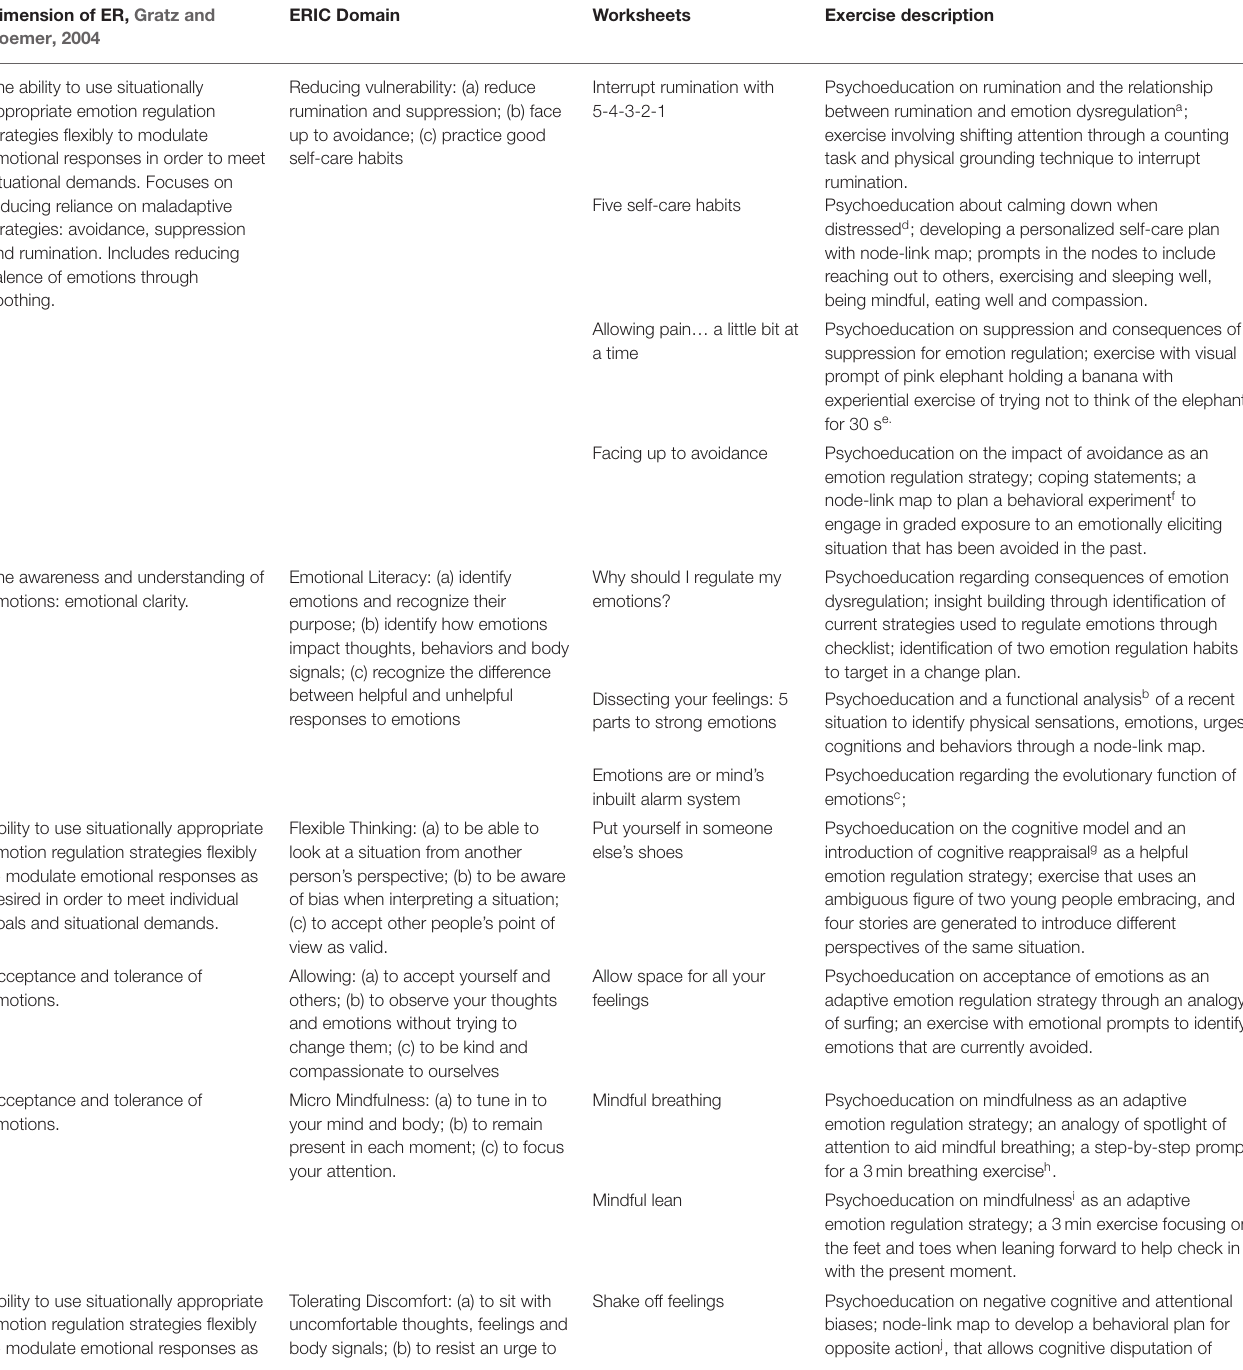
TABLE 1 | Content overview of the ERIC domains, worksheets and exercises delivered during the intervention. Dimension of ER, Gratz and Roemer,